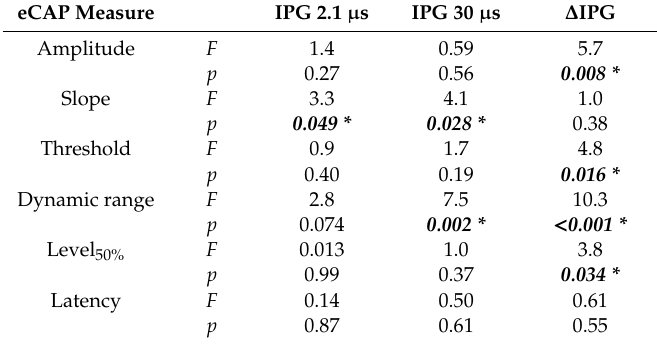
Table 1. Results from one-way ANOVAs on single-pulse eCAP characteristics for the BDNF, THF and untreated 6WD groups.